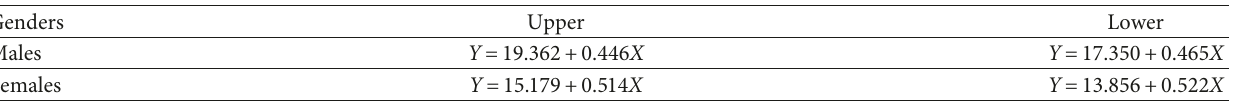
Table 3: Regression equations used to predict the sum of upper and lower canines and premolars crown widths in both genders.